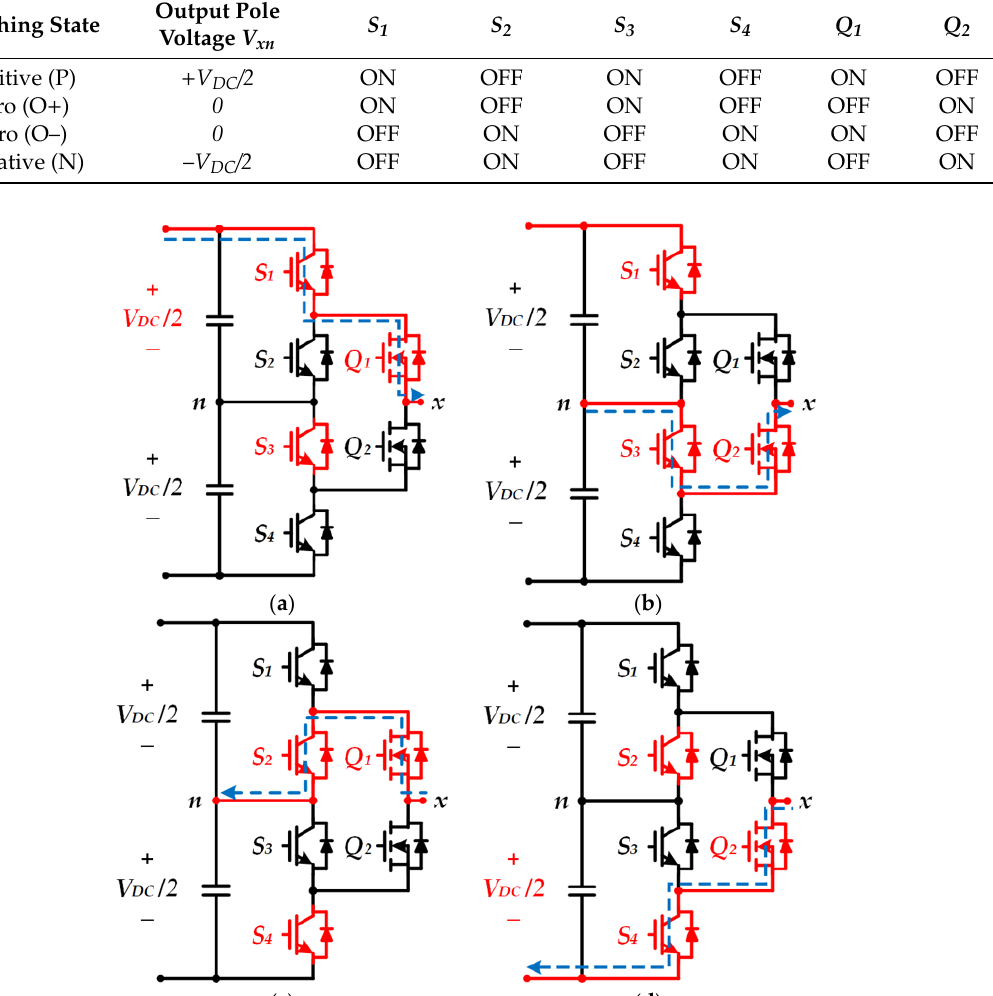
Figure 5. Switching states and current path of HANPC inverter: ( a ) positive state P; ( b ) positive zero state O+; ( c ) negative zero state O – ; ( d ) negative state N. state O + ; ( c ) negative zero state O–; ( d ) negative state Table 1. Switching states based on the switch status of the HANPC inverter.